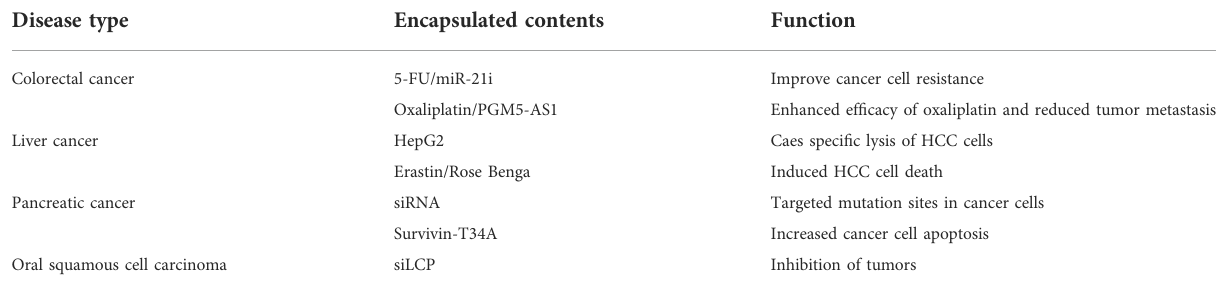
TABLE 2 Engineered exosomes in the digestive